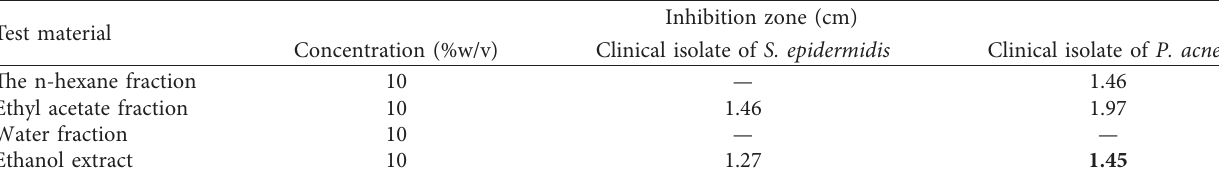
Table 5: Antibacterial activity fractions and ethanol extract of. cassava leaves to S. epidermidis and P. acnes clinical isolates.